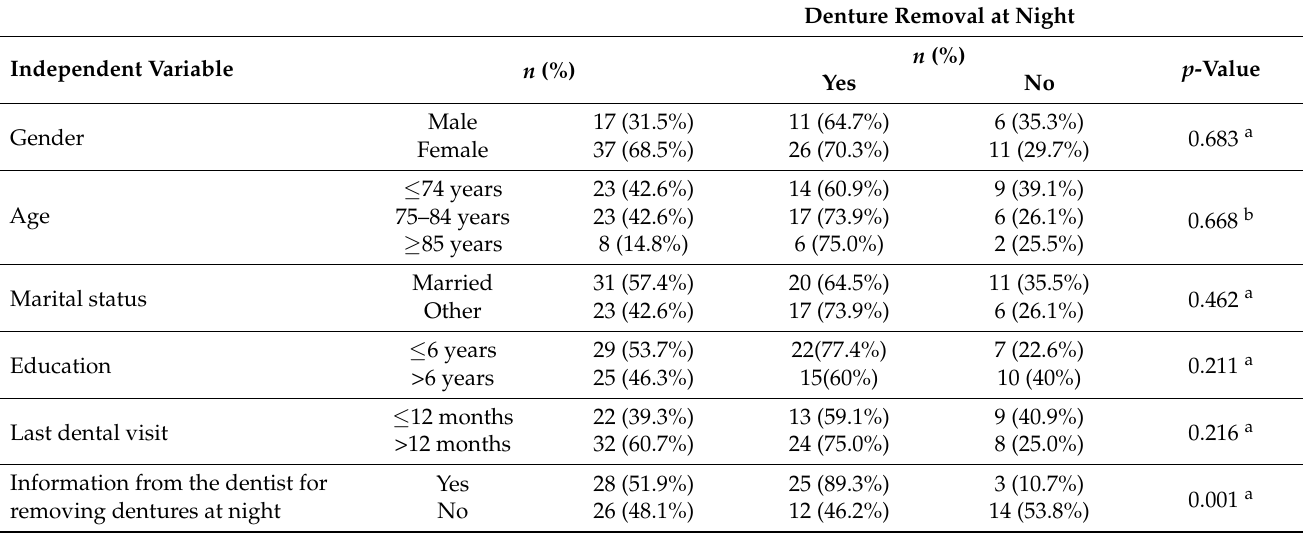
Table 10. The association of sociodemographic characteristics, dental visitation habits and information from the dentist with denture removal at night.